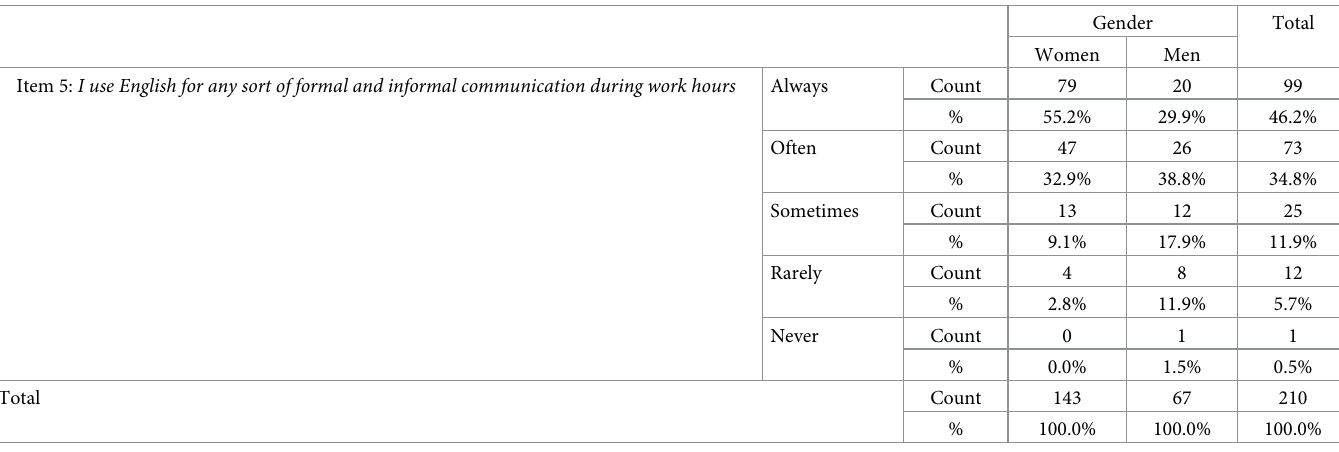
Table 9. English use for all types of formal and informal